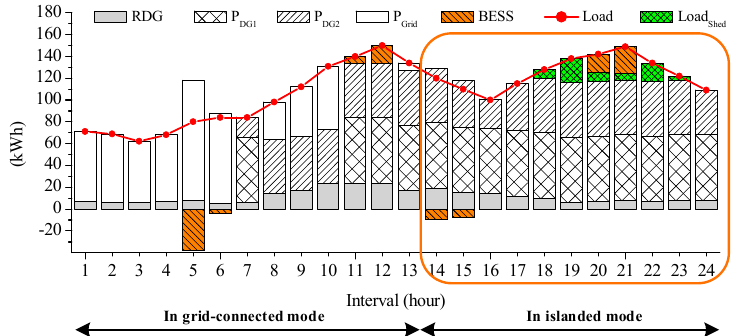
Figure 12. Schedule for all components considering the islanded mode from 14 h.